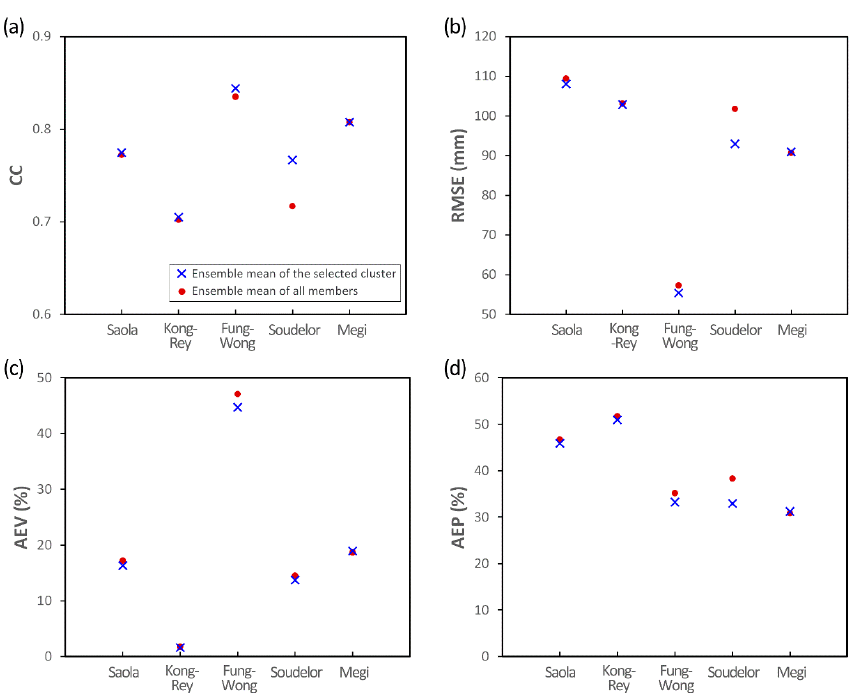
Figure 9. Performance measures of the proposed and the conventional strategies for five typhoons, ( a ) CC ; ( b ) RMSE ; ( c ) AEV ; ( d ) AEP .